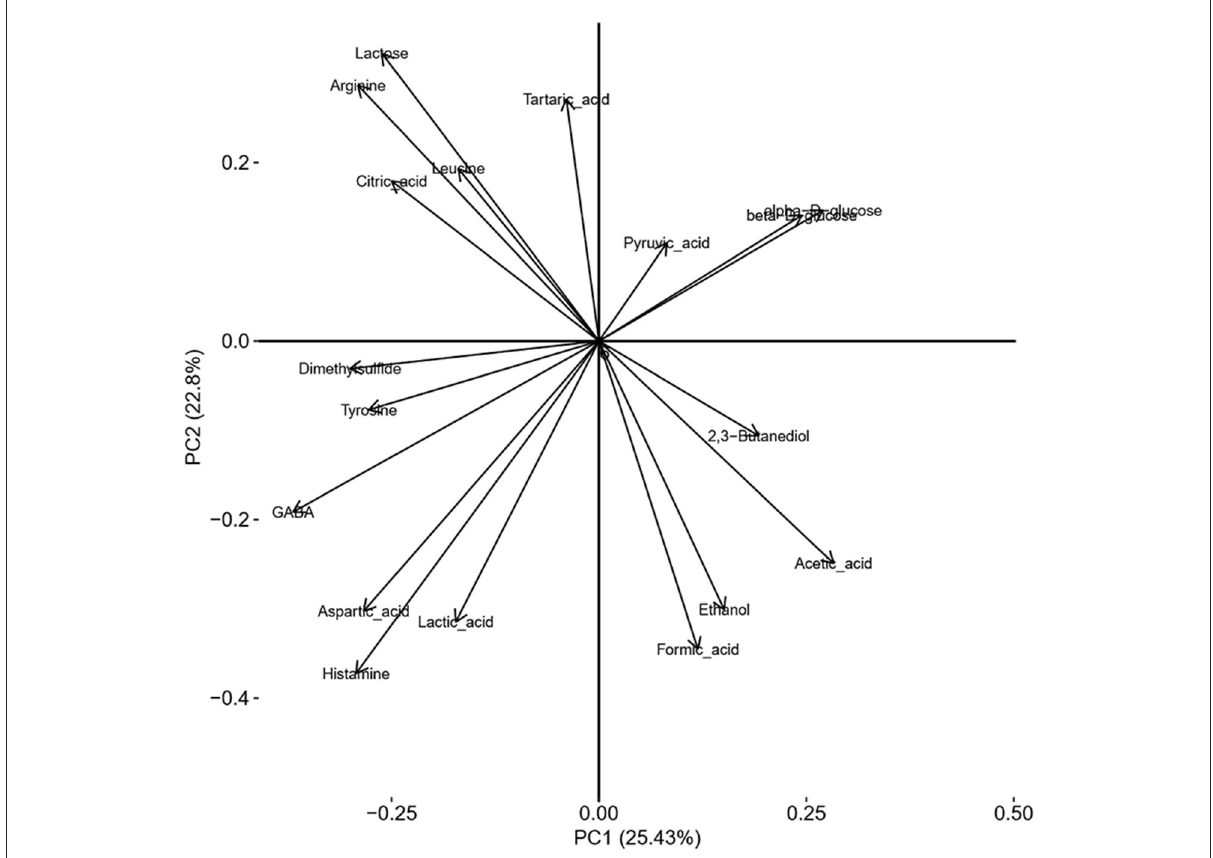
FIGURE6 Loading plot of a two-component PCoA model of NMR spectra showing sample clustering according to ingredient